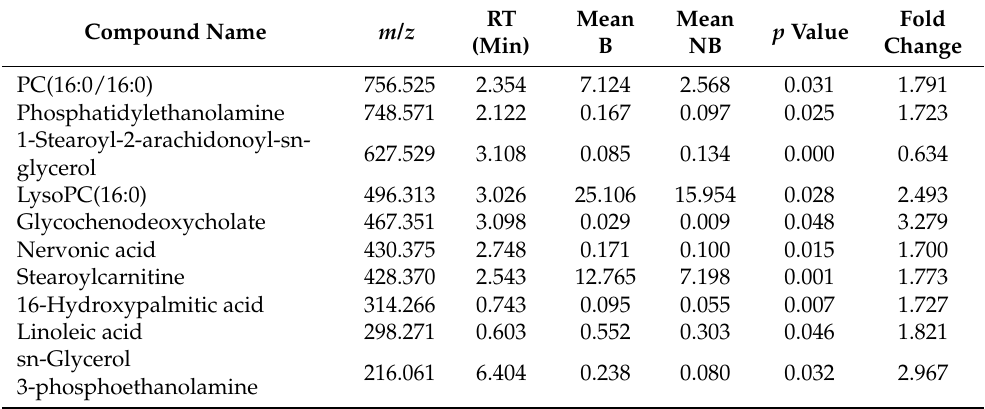
Figure 2. KEGG enrichment analysis of lipids metabolites sets detected from scent glands by LC- MS/MS. ( a ) Overview of enriched metabolite sets in positive ion mode; ( b ) overview of enriched metabolite sets in negative ion mode. Table 2. Identification of differentially expressed lipids detected in the scent glands during the breeding and non-breeding seasons in the positive ion mode of LC-MS/MS.